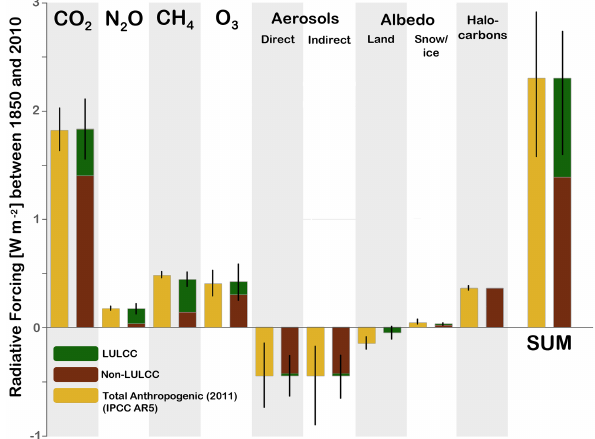
Figure 3. RFs for LULCC and other anthropogenic impacts esti- mated by this study for the year 2010 referenced to the year 1850. Total anthropogenic RF from the IPCC AR5 (Myhre et al., 2013) are shown for comparison (yellow). Error lines represent 1 σ uncer- tainties in total anthropogenic RF for the IPCC bars and 1 σ uncer- tainties in LULCC RFs as computed in this study (green bars; data given in Table 2). The “SUM” bars show the total RF when all forc- ing agents are combined. Note that aerosol ERFs are scaled to IPCC AR5 values, as explained in the main